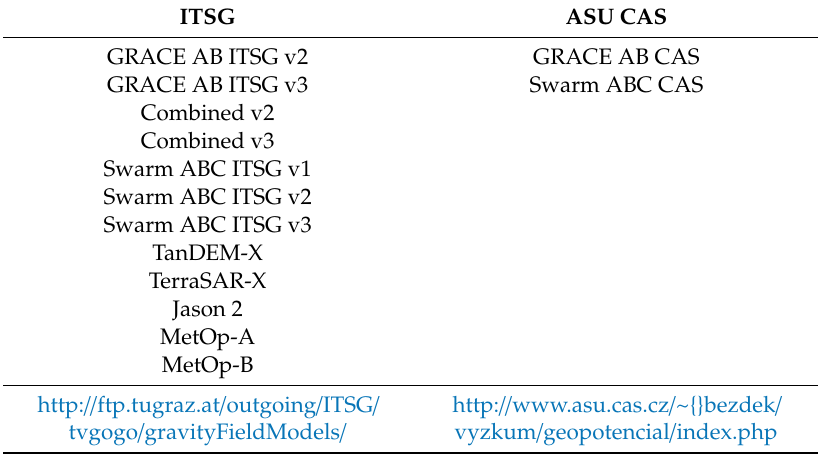
Table 2. Earth gravity field models from kinematic orbits of low-Earth-orbit (LEO) satellites provided by ITSG and ASU CAS used in this study, together with data sources.